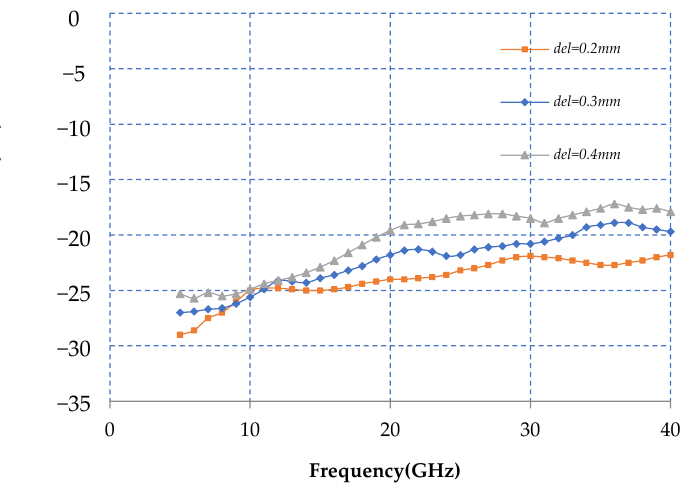
Figure 15. Return loss corresponding to the horizontal gap.